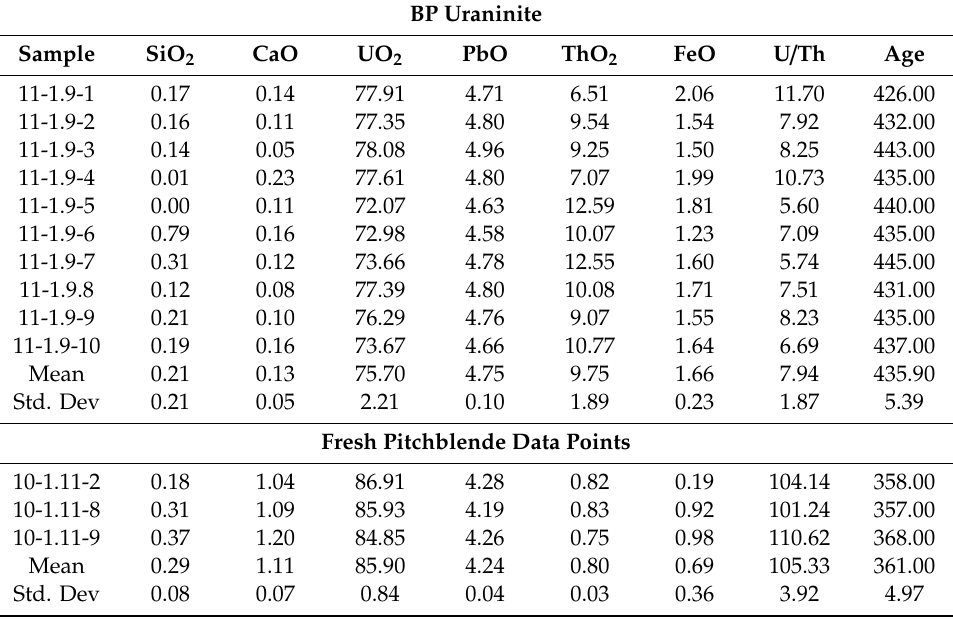
Table 2. Major element concentrations and calculated age of fresh uraninite and pitchblende from the Jiling uranium